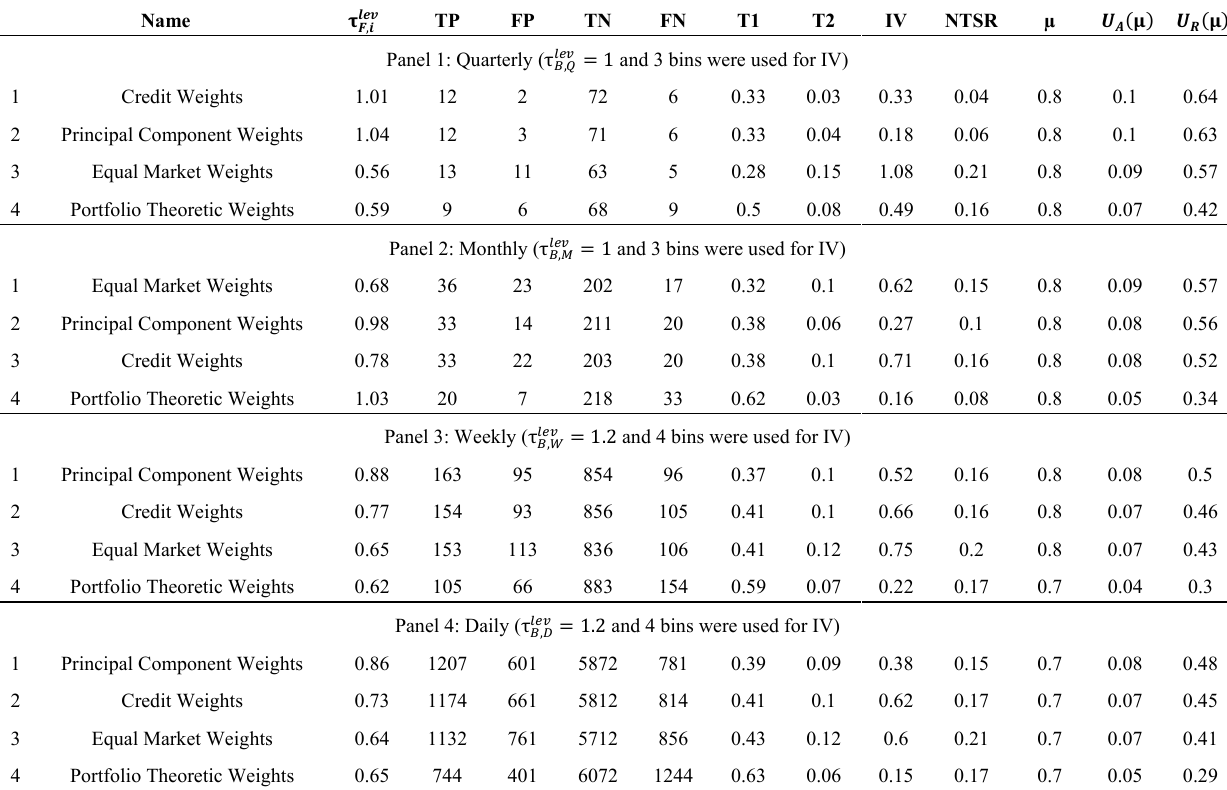
Figure 2. Standardized stress series under the four proposed weighting schemes. Table 3. Comparison of information quality of alternative aggregation